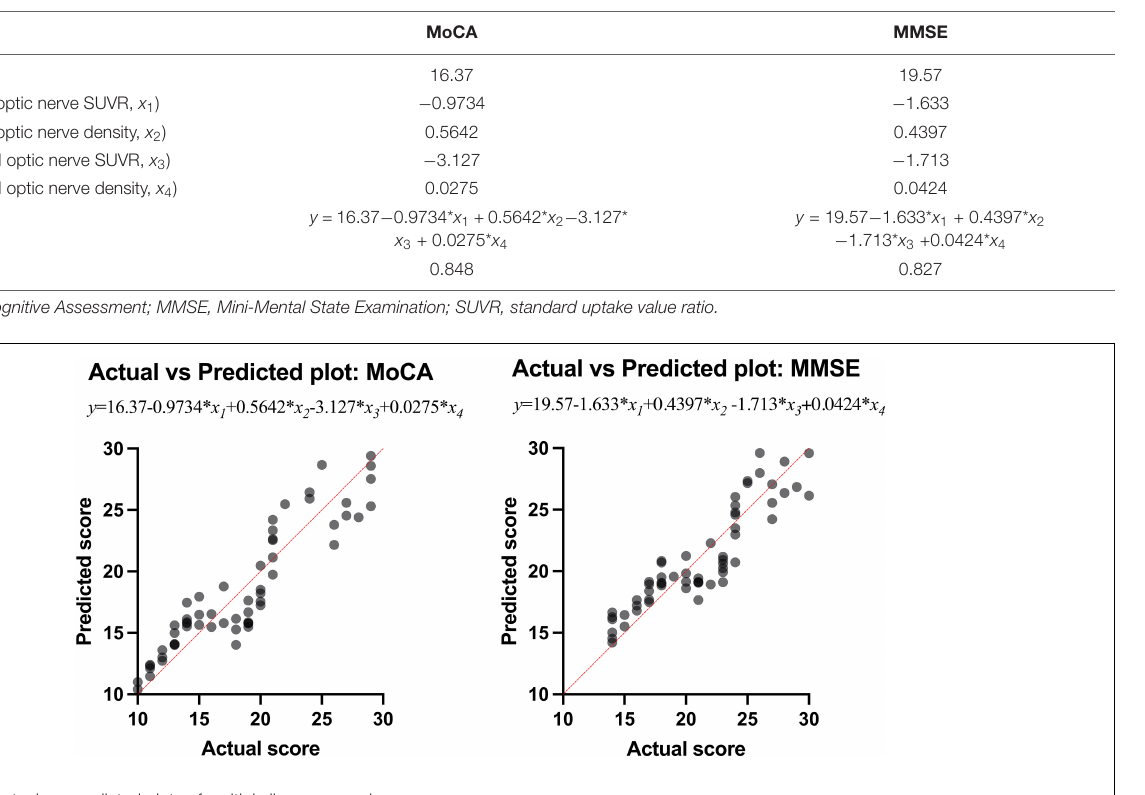
FIGURE 5 | The actual vs. predicted plots of multiple linear